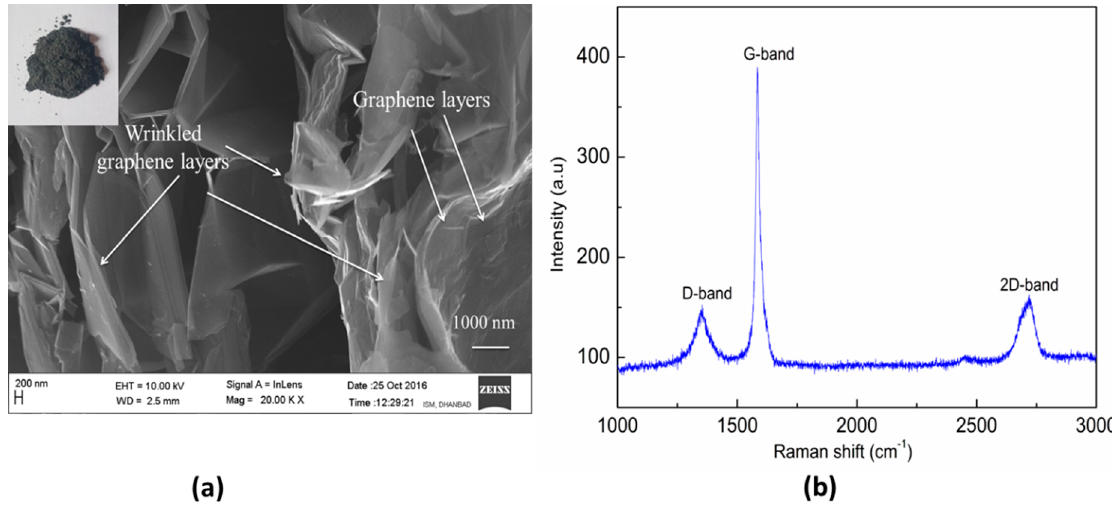
Figure 5. ( a ) High magnification field-emission scanning electron microscopy (FESEM) image of the graphene nanoplatelets (GNP) and ( b ) Raman spectra of GNP.